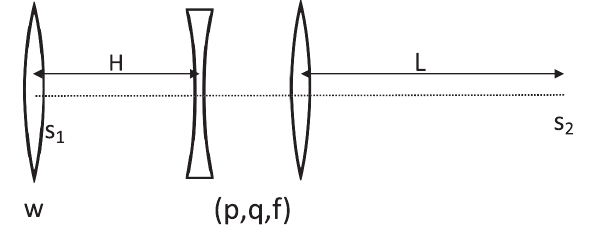
FIG. 1. A schematic layout of half of a cell with reflection